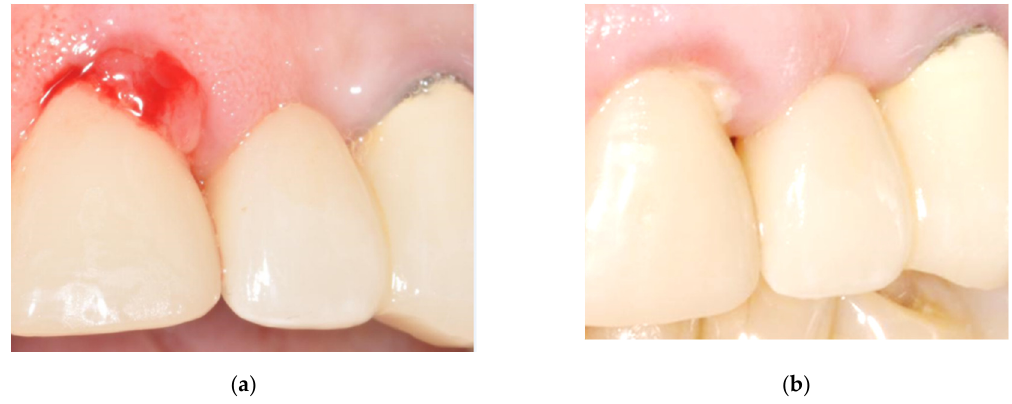
Figure 16. Clinical case No. 4: dental implant ( a ) before and ( b ) after the treatment.